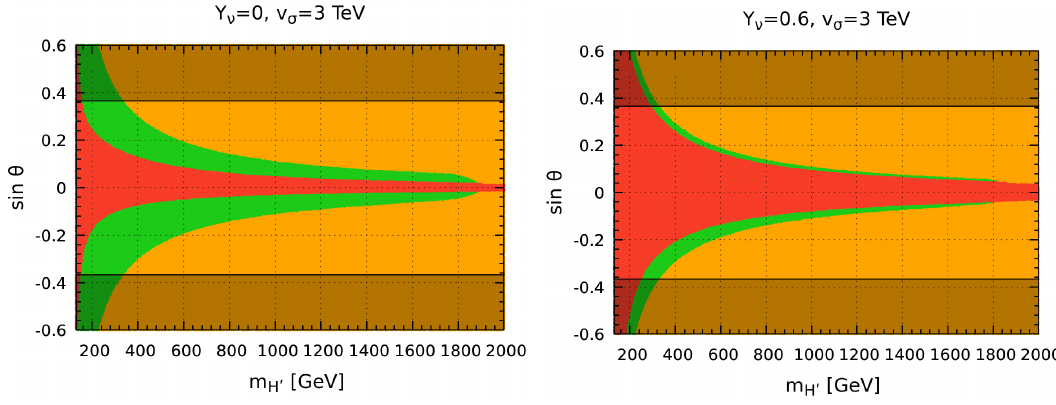
Figure 17 . Same as in figure 16 but for v σ = 3